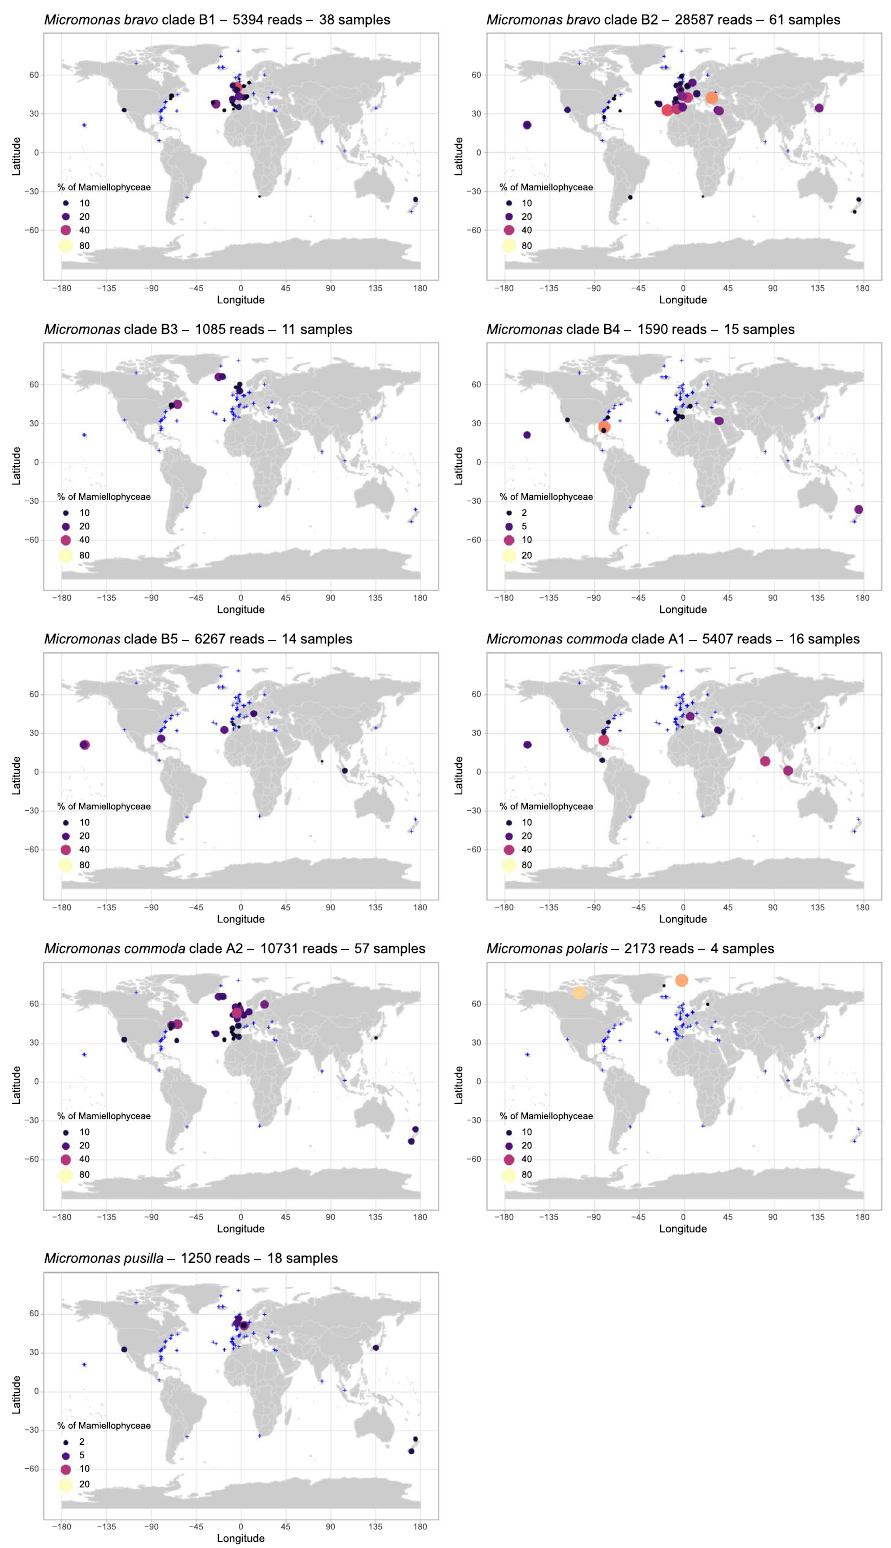
Figure 5. Distribution of the major Micromonas ASVs for OSD2014 (LGC). Legend as in Fig. 3. A zoomed-in map of European waters is provided in Fig.